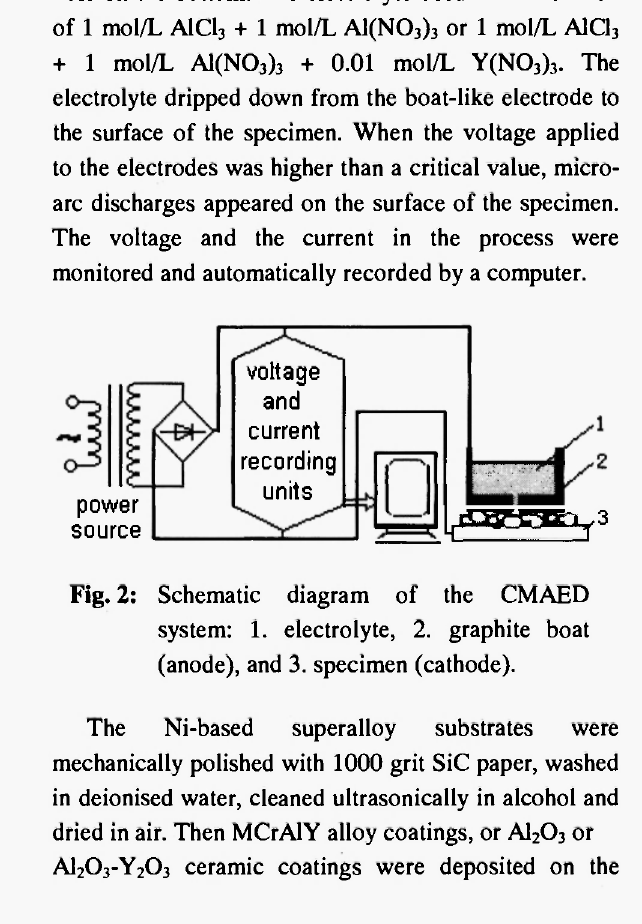
Fig. 2: Schematic diagram of the CMAED system: 1. electrolyte, 2. graphite boat (anode), and 3. specimen